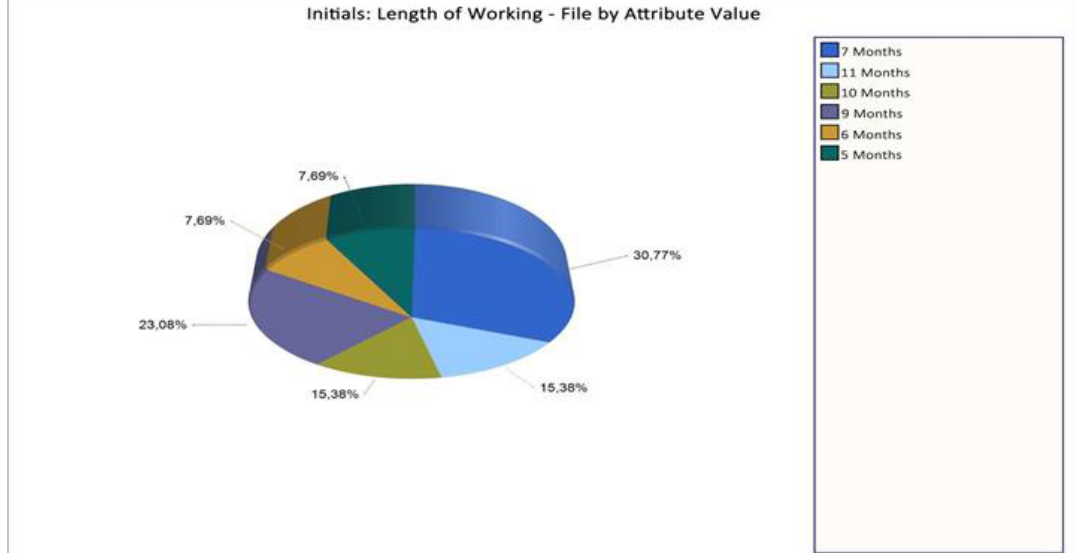
Fig. 2. Participants distribution based on length of work